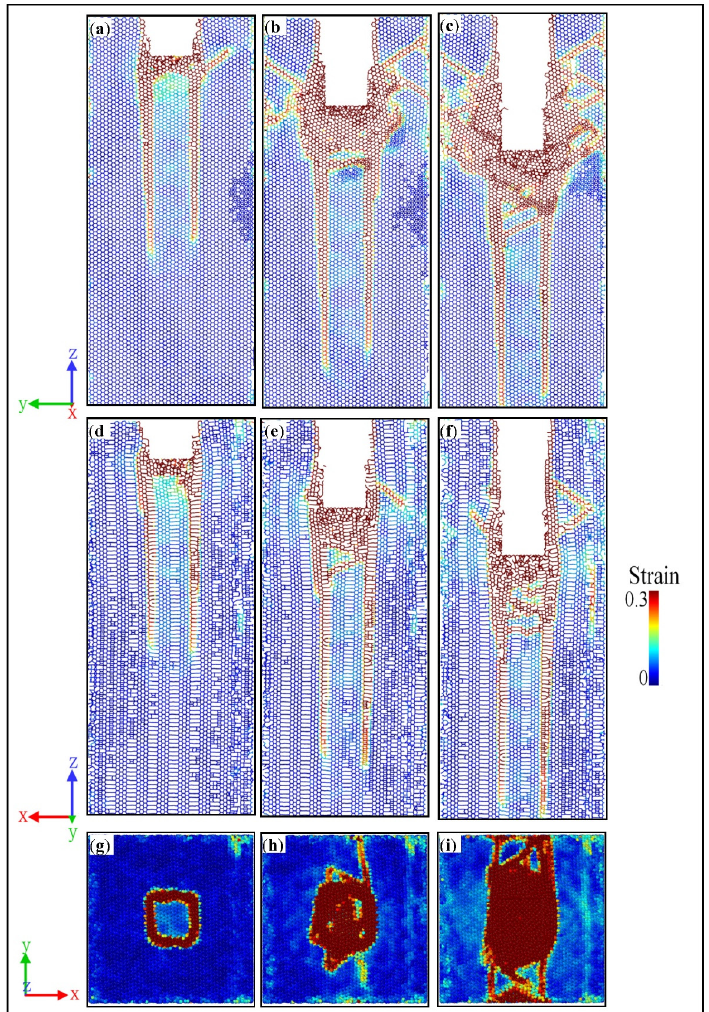
Figure 7. Shear strain nephogram of 6H-SiC (2110) crystal plane with different indentation depths. ( a , d , g ) are the shear strain nephograms in different directions when the indentation depth is 3 nm, ( b , e , h ) are the 6nm indentation depth, ( c , f , i ) are the 9 nm indentation